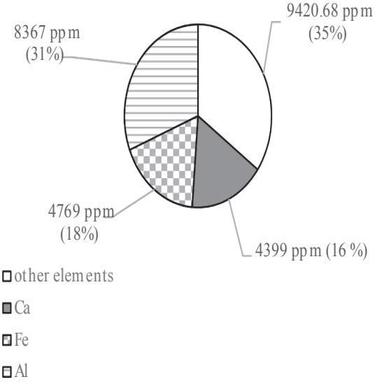
ICP plasma spectroscopy data concentrations of lime stone sample.